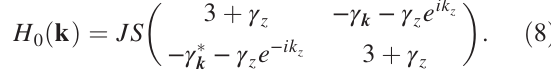
FIG. 3. (a) Temperature-dependent renormalization of the Dirac dispersion near the K point. The bare and renormalized spectra are shown in red and black lines. (b) Temperature-dependent renormalization of the magnon energy spectrum copied from Ref. [34] overlaid with our theory (red). The green and blue arrows in both panels are used as a guide to the eye and point to the corresponding features in the spectrum. In panel (b), the horizontal dashed line represents the energy renormalization due to the constant Hartree term [Eq. (3)]. The momentum